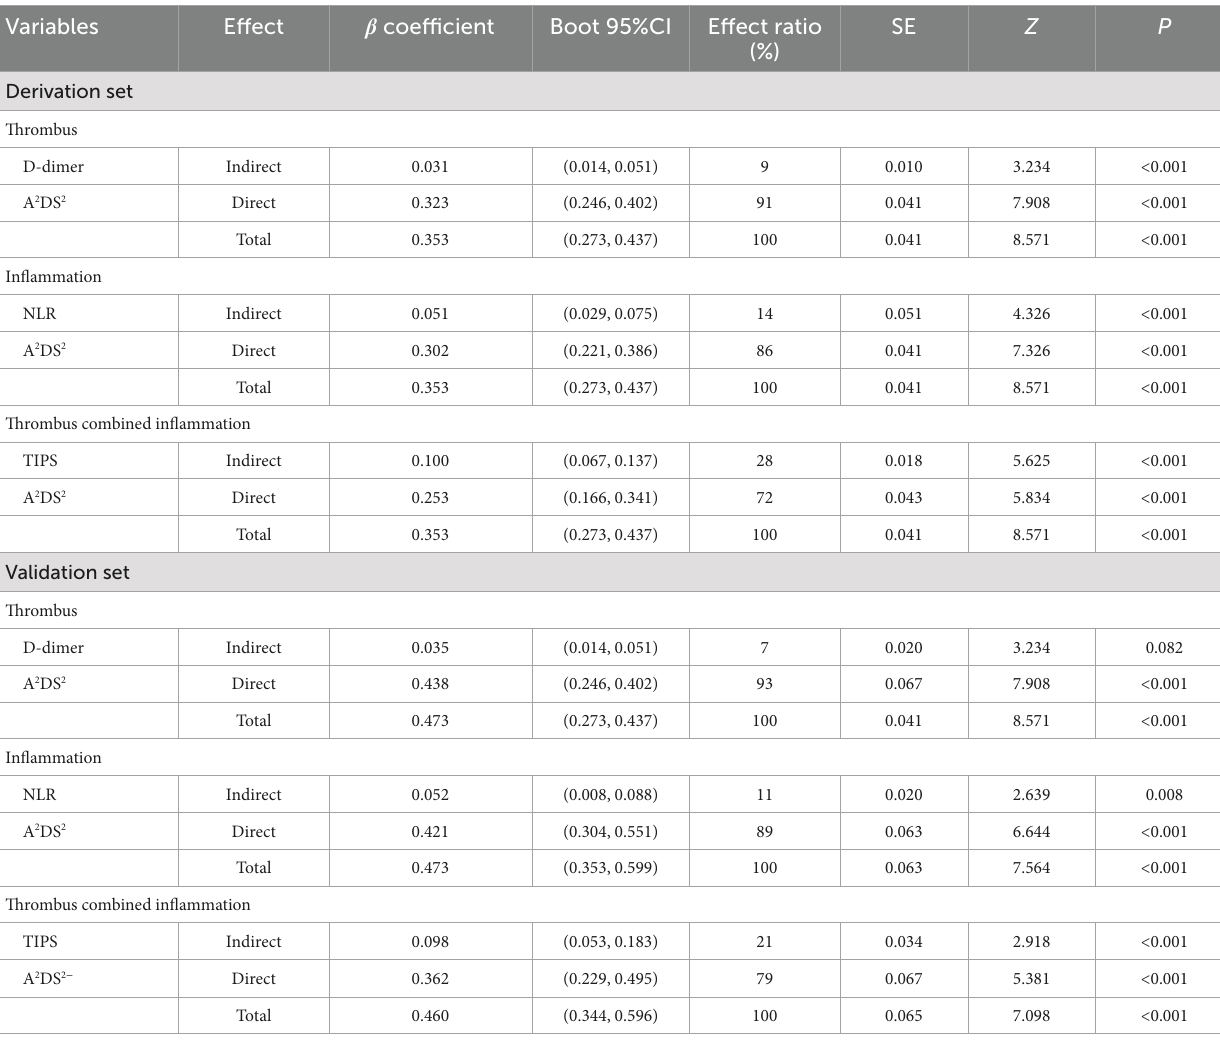
TABLE 4 Direct and indirect effects of D-dimer, NLR and TIPS on A 2 DS 2 and stroke-associated pneumonia in both the derivation set and validation set.